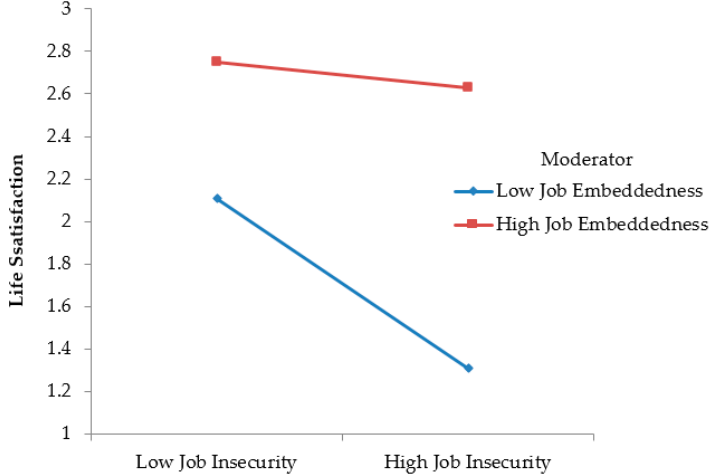
Figure 1. The two-way interaction effects of job insecurity and job embeddedness on employees’ life satisfaction.